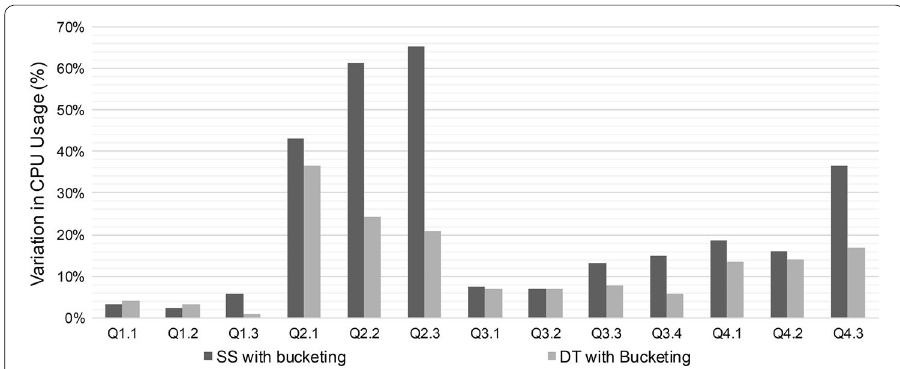
Fig. 4 CPU usage: bucketing by “Orderkey” (Presto, SF